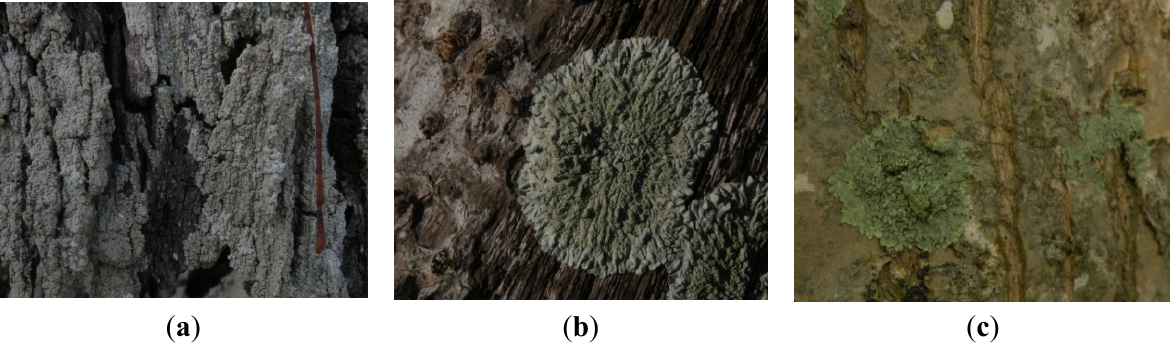
Figure 3. Foliose lichens of Heron Island. ( a ) Dirinaria picta on she-oak ( Casuarina equisetifolia ) bark; ( b ) Pyxine cocoes on she-oak bark; ( c ) Hyperphyscia adglutinata on Pisonia ( Pisonia grandis ) bark. White polygons in 3c are the sterile thalli found commonly throughout the study on